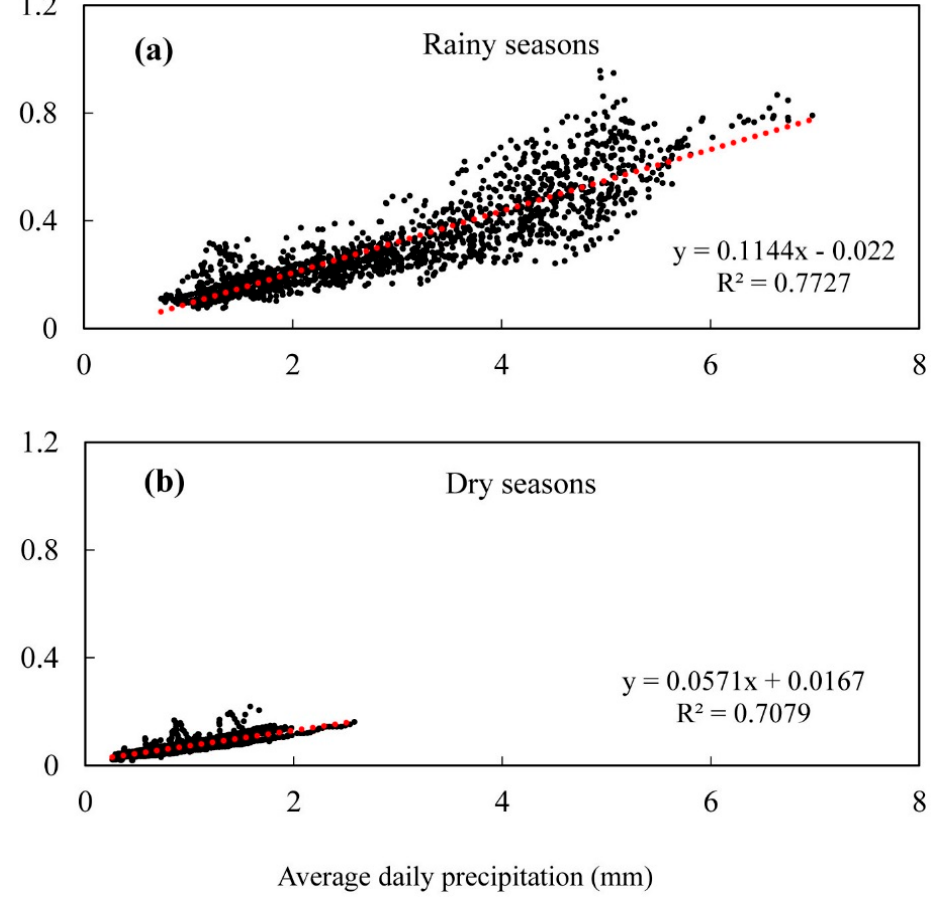
Figure 6. Daily discharge estimates using segmented TRMM precipitation data in the Nuxia basin. ( a ) Linear regression between normalized daily discharge and filtered basin-averaged daily precipitation in the rainy season. ( b ) Linear regression between normalized daily discharge and filtered basin-averaged daily precipitation in the dry season.